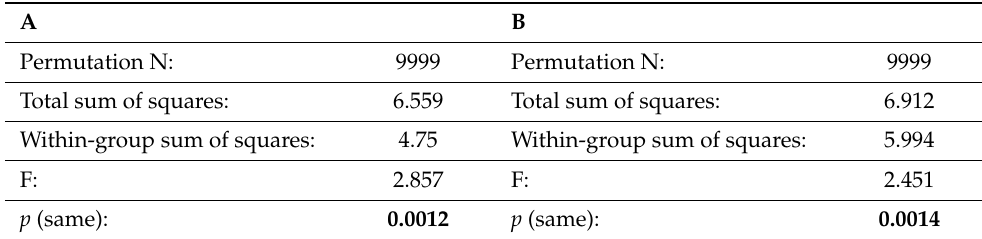
Figure 4. Two-way Hierarchical cluster Analysis (HCA) of the EOs obtained from all the studied plants belonging to the Mentheae tribe. Table 4. Effects of Subtribes ( A ) and Tribes ( B ) on the essential oils (EOs) according one-way PER- MANOVA